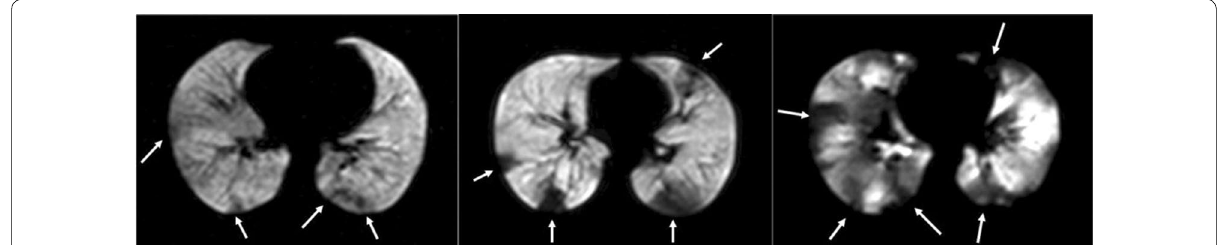
Fig. 4 Hyperpolarized helium-3 MRI axial slice of a mild asthmatic ( left panel ), a moderate asthmatic ( middle panel ), and a severe asthmatic ( right panel ). As depicted by the arrows , increasing severity of disease is associated with increasing ventilation defects and ventilation heterogeneity (reproduced with permission from